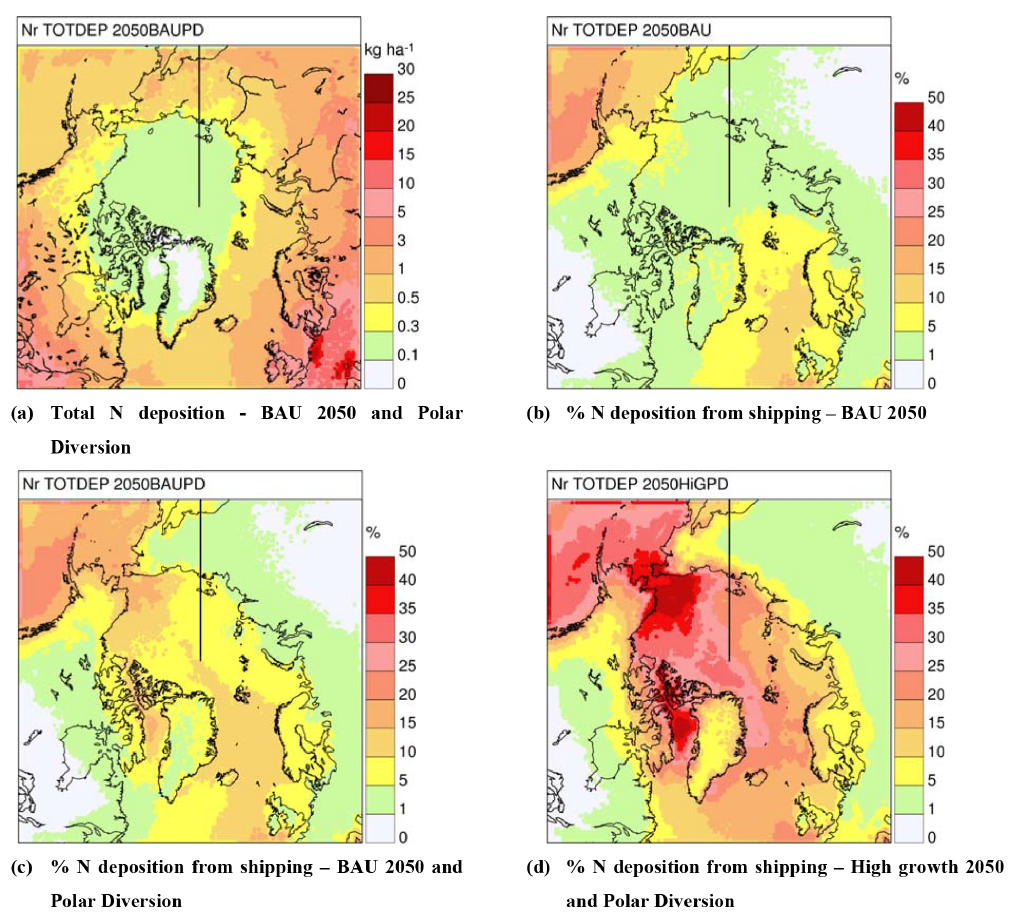
Figure 11. (a) The total nitrogen deposition across the Arctic and Nordic region in the BAU 2050 Polar diversion scenario in the DEHM d02 domain. Panels (b) and (c) display the contribution from shipping without and with the polar diversion, while (d) displays the contribution in the High-Growth traffic scenario (including the polar